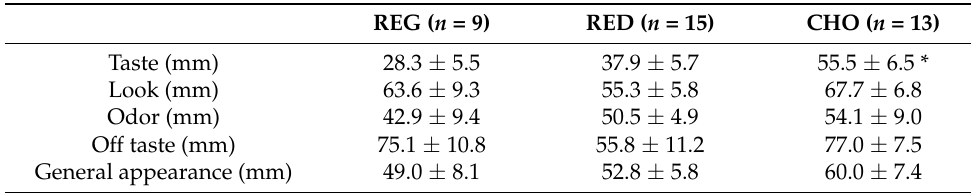
Table 3. Palatability assessments of the three test meals 1,2 .